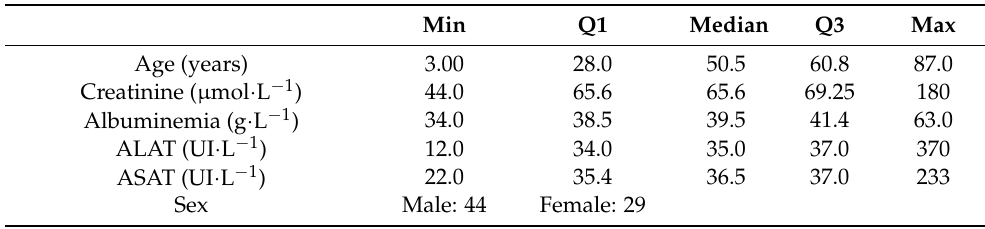
Table 4. Individual covariate